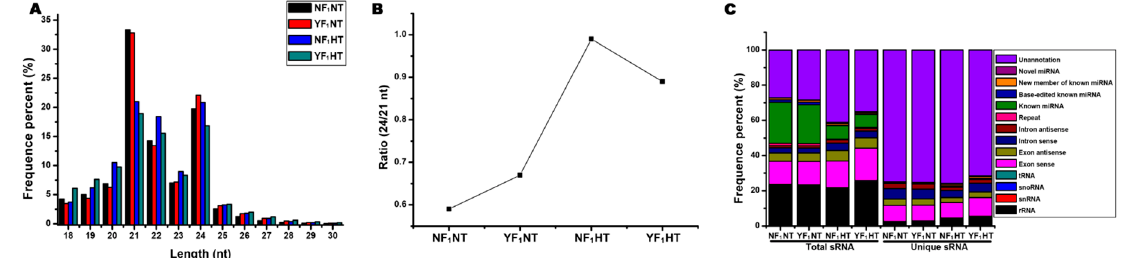
Figure 1. Characterization of small RNA (sRNA) in the flower bud of soybean cytoplasmic male sterility (CMS)-based F 1 under high temperature (HT) stress. ( A ) Length distribution of sRNA sequences. ( B ) Ratio of 24/21 nt sRNAs. ( C ) Annotation of sRNA and its distribution in total sRNA and unique sRNA.